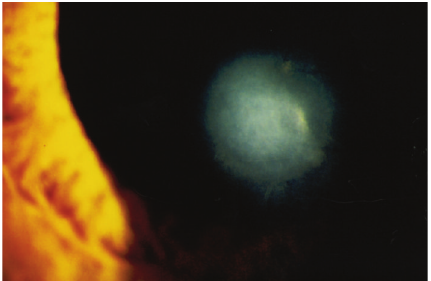
Figure 3: High magnification shows a relatively dense opacification of the cornea. Note the retrocorneal melanin granules at the edge of the stromal opacity.